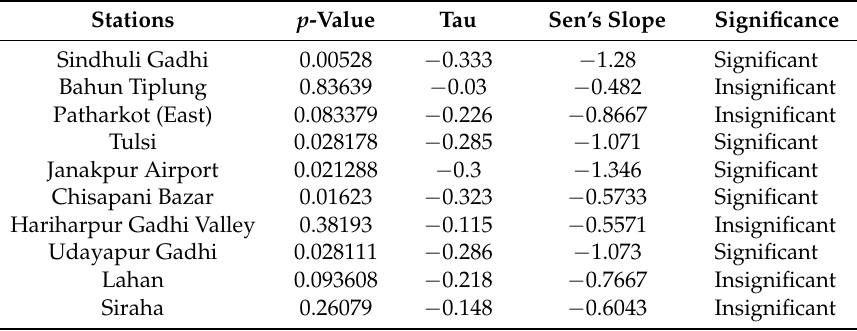
Table 9. Winter Rainfall trend.